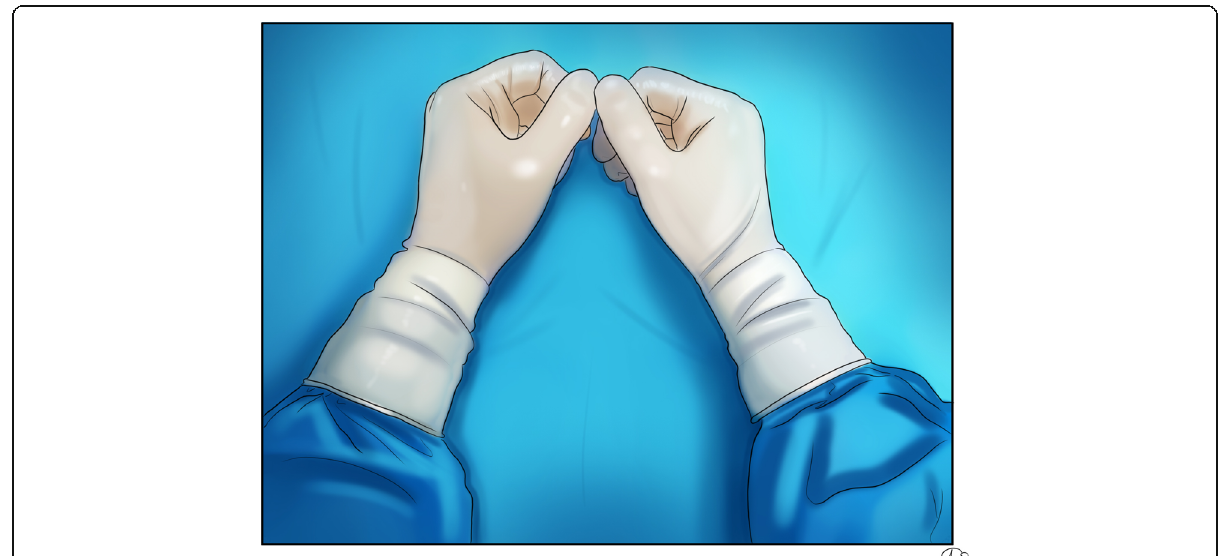
Fig. 6 Arm-length surgical gloves that completely cover the wrist area